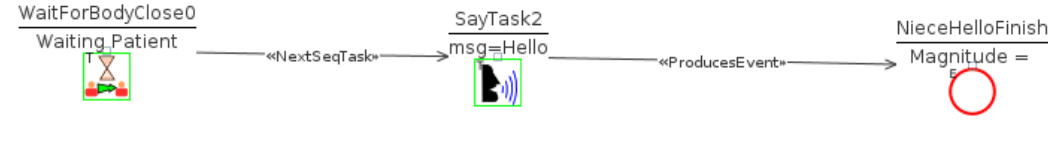
Figure 4. Initiating the